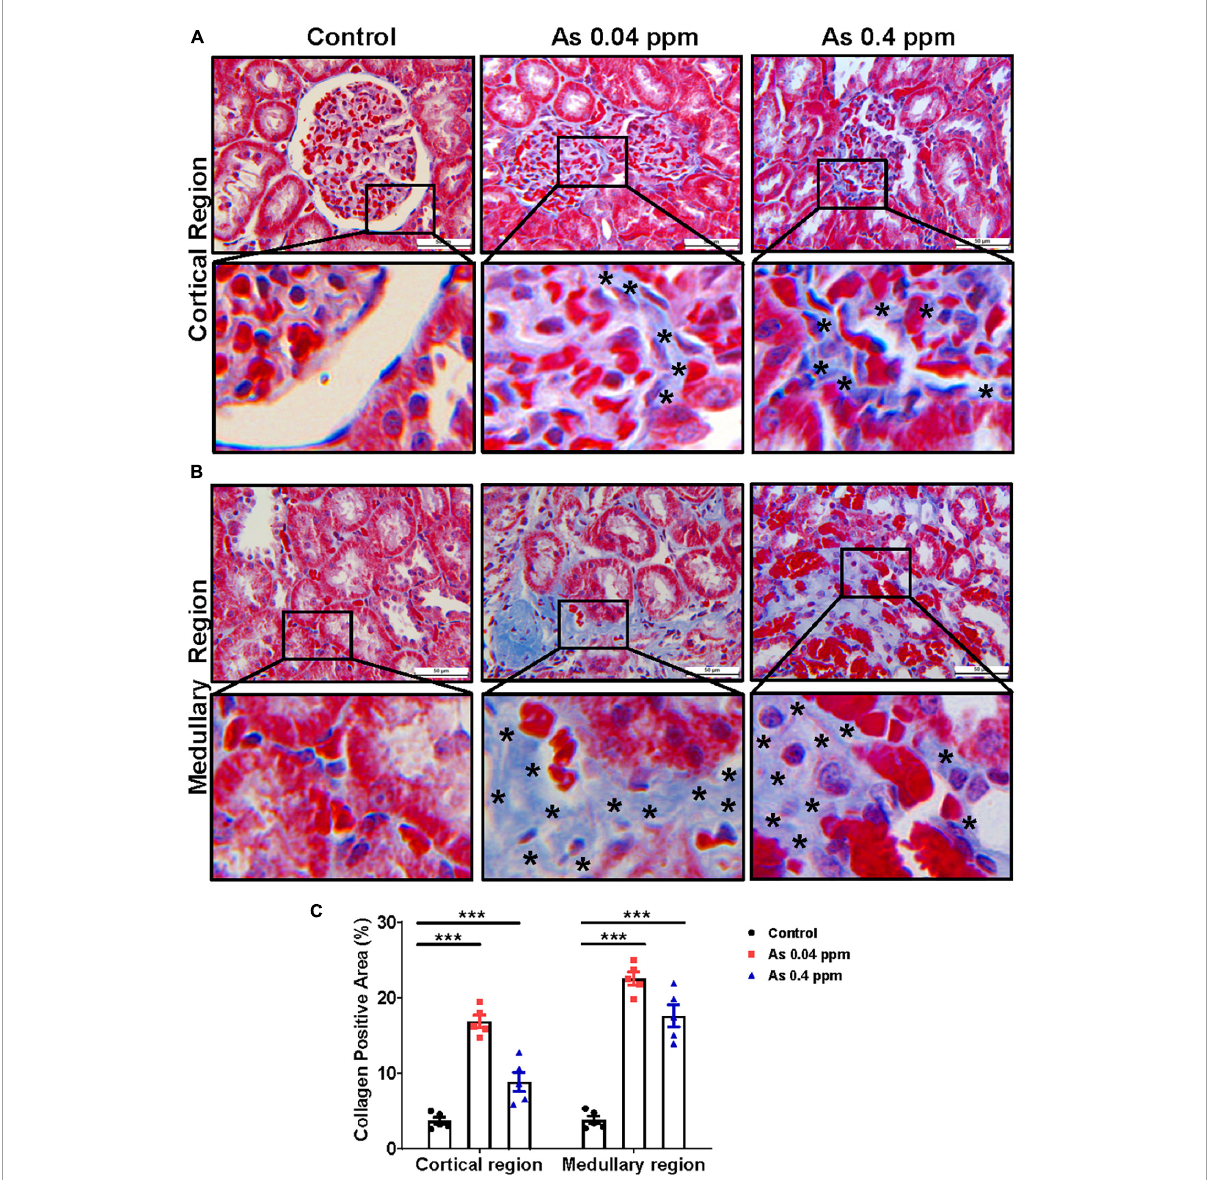
FIGURE9 Prenatal As exposure promotes collagen deposition in the kidney. Kidney sections of exposed animals were stained with trichrome staining at 38 weeks of age. The blue stained regions represent the collagen. The level of collagen is significantly higher around the glomerular region and their enlarged inset view shows the specific site of collagen deposition (A) . Collagen deposition was also prominent in the medullary region. The specific site of collagen deposition is shown in the inset view (B) . The asterisk shows the site of collagen deposition. The level of collagen in the glomerular and medullary region (C) is graphically represented. Bar = 50 µ m. *** p <